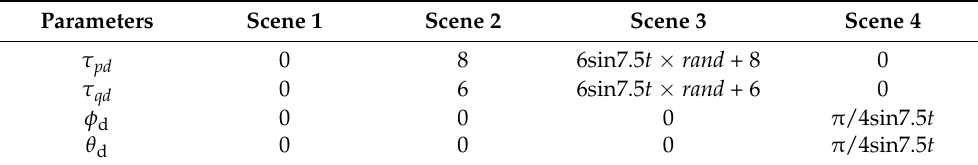
Table 5. Parameters of IISMC control